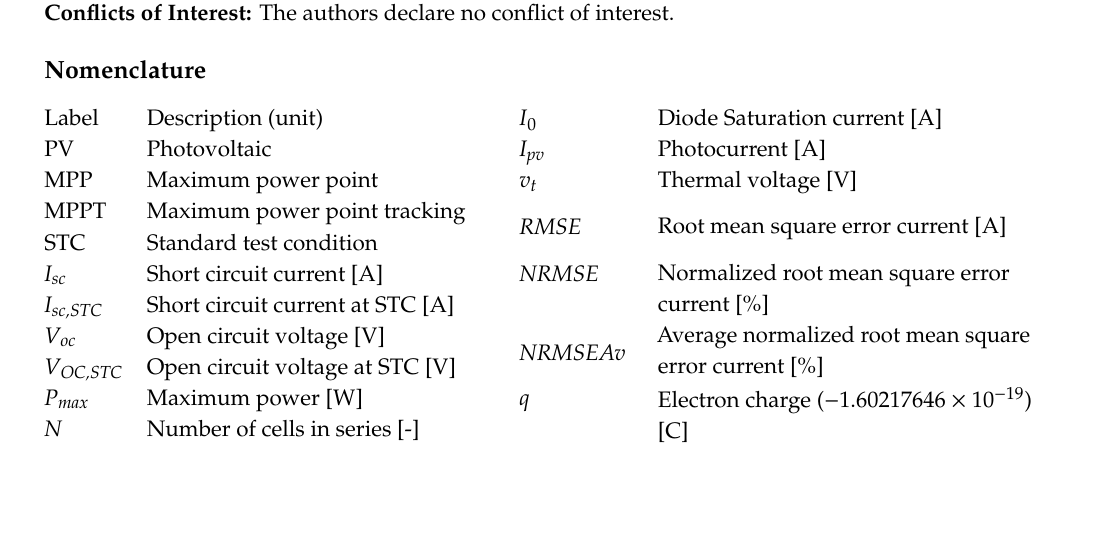
Figure 9. Bar chart of the average error on the variations of solar irradiance and temperatures of all the examined methods